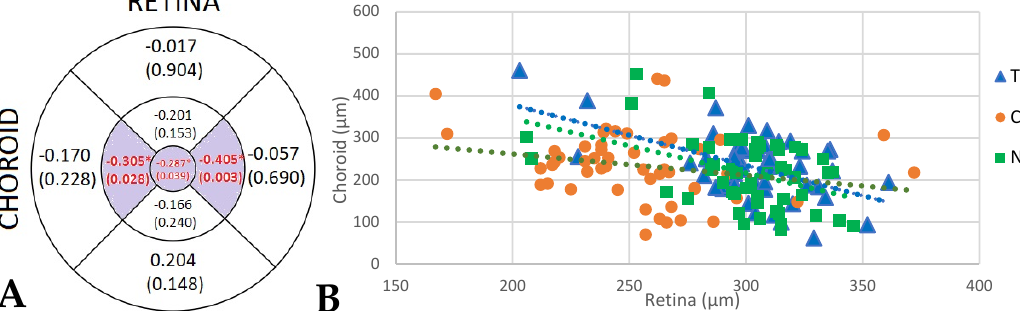
Figure 4. ( A ) Correlation coefficients and statistical significance ( p -value) between choroidal thickness and retinal thickness in DM2 patients in the nine areas of the early treatment diabetic retinopathy study (ETDRS) grid. Left areas represent the temporal quadrants, and right areas represent the nasal quadrants, as if the figure represents a right eye. The values that reached statistical significance ( p <0.05) are shown in red with a purple background and marked with (*). ( B ) Scatter plot with regression lines correlating retinal and choroidal thicknesses in temporal internal (TI), central (C), and nasal internal (NI) areas.